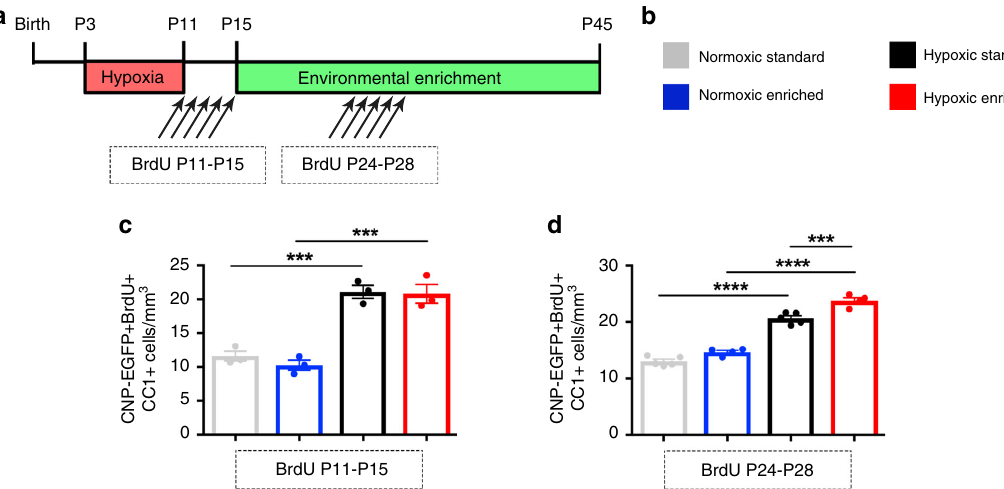
Fig. 2 Environmental enrichment promotes oligodendrogenesis after perinatal brain injury. a Experimental paradigm. BrdU was administered either from P11 to P15 ( c ) or P24 − P28 ( d ). b Experimental groups . c Quanti fi cation of total EGFP + BrdU + CC1 + cells at P45, following BrdU injections immediately after HX (P11 − P15) ( n = 3 per group) (from left to right: *** p = 0.0006, *** p = 0.0008). d Quanti fi cation of total EGFP + BrdU + CC1 + cells at P45, following BrdU injections during EE (P24 − P28) (NX, n = 5; NX-EE, n = 4; HX, n = 5; HX-EE, n = 4) (**** p < 0.0001, *** p = 0.0008). Data expressed as mean ± SEM. One-way ANOVA followed by a Tukey ’ s post hoc test for multiple comparisons was used to compare differences between groups. Source data are provided as a Source Data fi